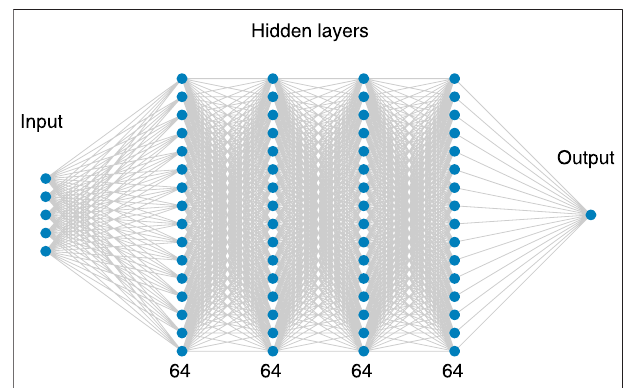
FIGURE 4 | Illustration of the ANN architecture with 4 hidden layers, each with 64 nodes, where only a smaller number of nodes is shown in this fi gureforclarity.Furthermore,theinputinthis fi gureis5-dimensional,butinthe present paper the input dimension varies from 3 to 236, see Table 3